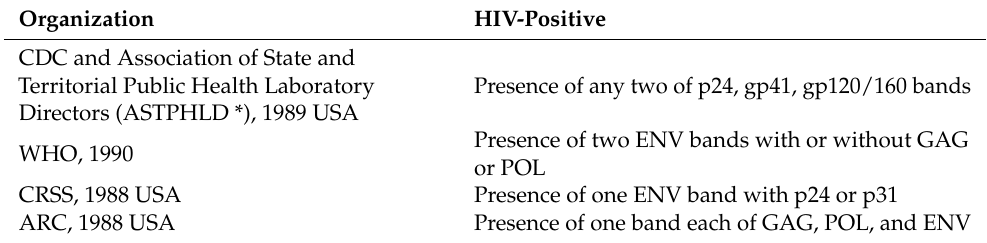
Table adapted from manufacturer’s (MP Biomedicals) product insert. * ASTPHLD was renamed Association of Public Health Laboratories (APHL) in